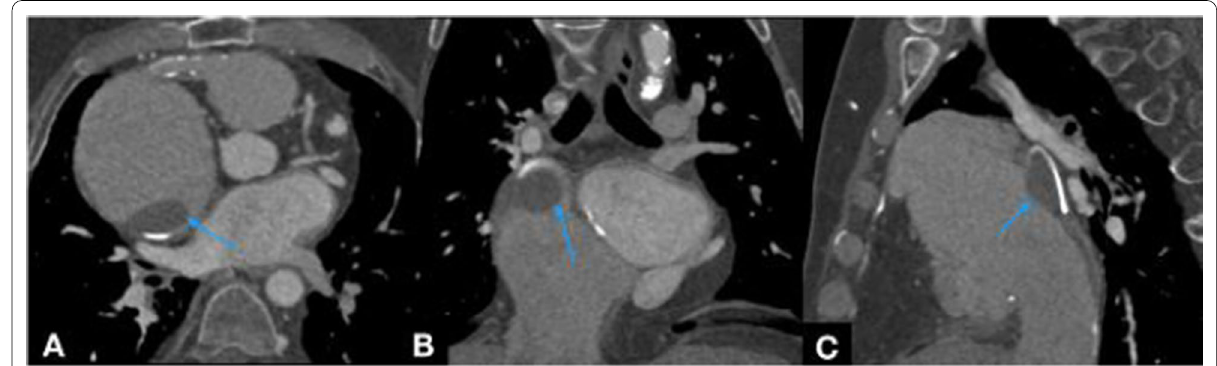
Fig. 23 ECG-gated CT study of an atriopulmonary Fontan circulation performed for congenital tricuspid atresia. Axial, coronal and sagittal views in the soft tissue window ( A – C ): Large thrombus seen in the right atrium (blue arrows) adhered to the atrial wall. Re-used with permission from Fontan circulation in an adult: A guide for the radiologist. Arzanauskaite M, Nyktari E, Voges I. ESTI-ESCR 2018 /